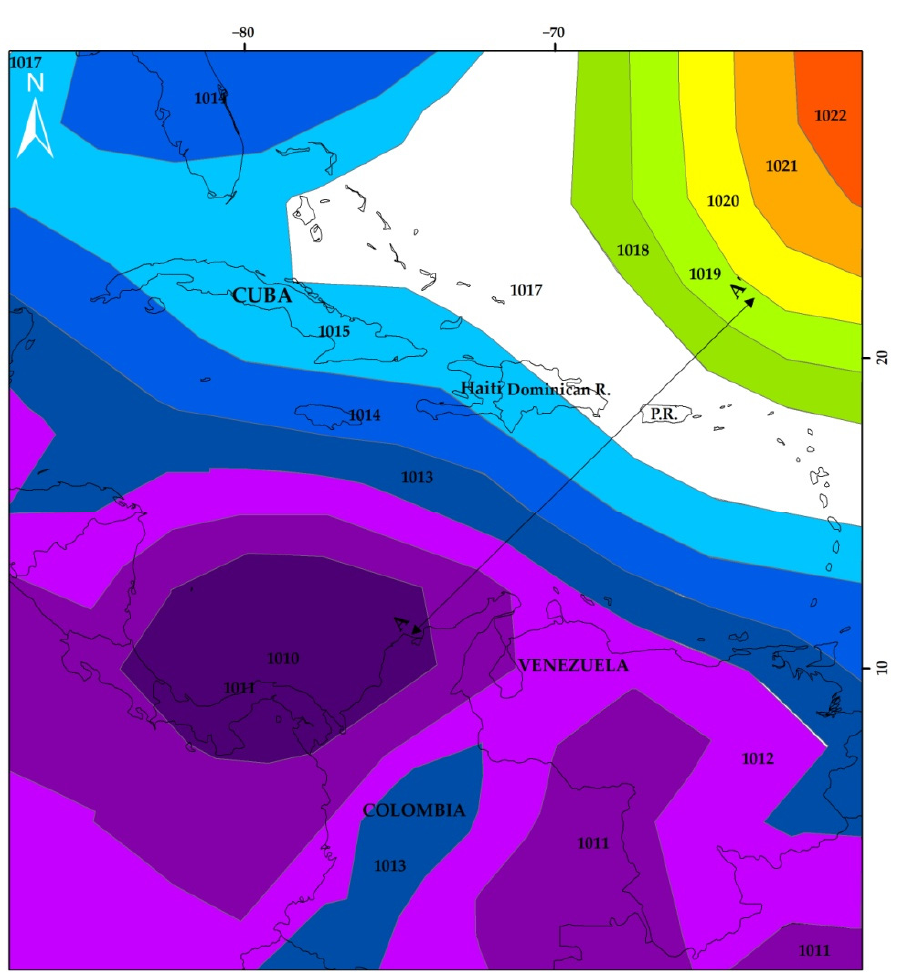
Figure 3. Sea level pressure (mb) composite mean for 26 May 1988. Section A-A’ was traced to capture the gradient in SLP before a breaching event took place. Note that Puerto Rico was abbre- viated as P.R. (Source of SLP values on https://psl.noaa.gov, accessed on 16 July 2022).